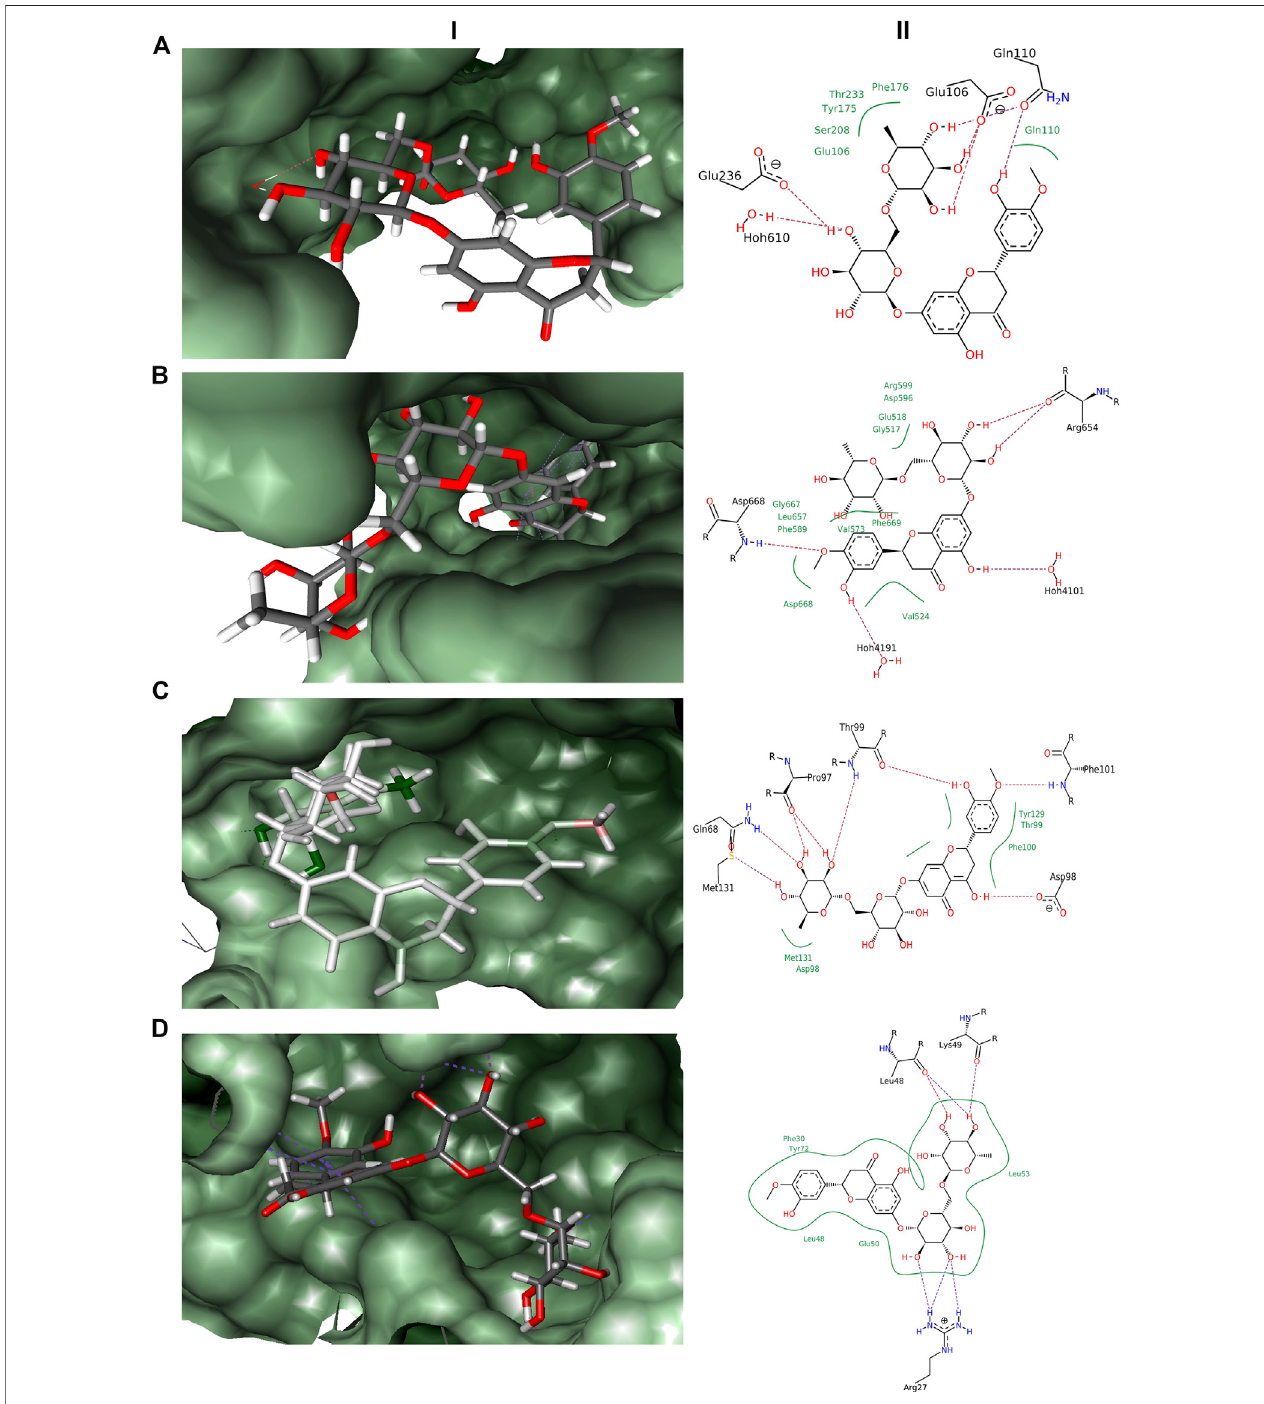
FIGURE1| DockingresultsobtainedfromLeadITforthefourreceptorswithhesperidin. (A) 3Dand2DinteractiondiagramofHesperidinwithNMDARreceptor. (B) 3Dand2DinteractiondiagramofHesperidinwithTRKreceptor. (C) 3Dand2DinteractiondiagramofHesperidinwithGABAreceptor. (D) 3Dand2Dinteractiondiagram of Hesperidin with Interleukin-10 receptor; (i) 3D pose, and (ii) 2D pose.